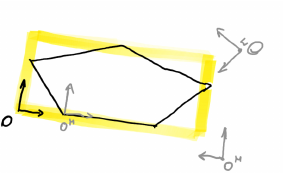
Figure 6. CRS for the checks calculations ( O , in black) and